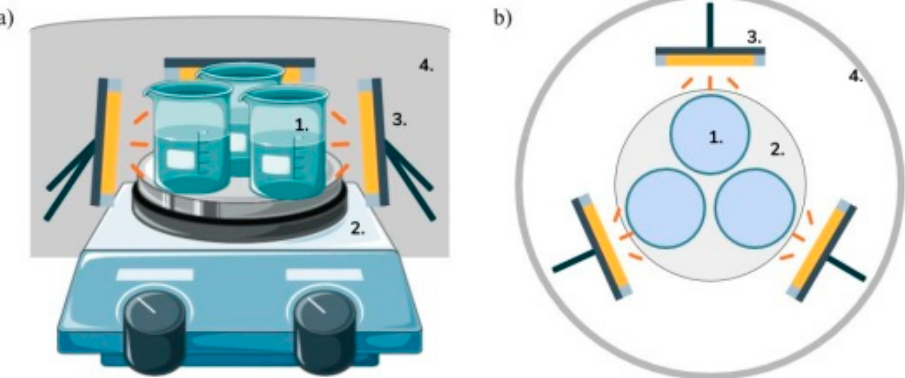
Figure 12. Setup of the photodegradation experiment ( a ) as seen from the front and ( b ) as seen from the above. 1. Beaker containing 100 mg of Pc@TiO 2 and 100 mL of IBU solution; 2. magnetic stirrer; 3. UV or Vis lamp; 4. aluminum foil.